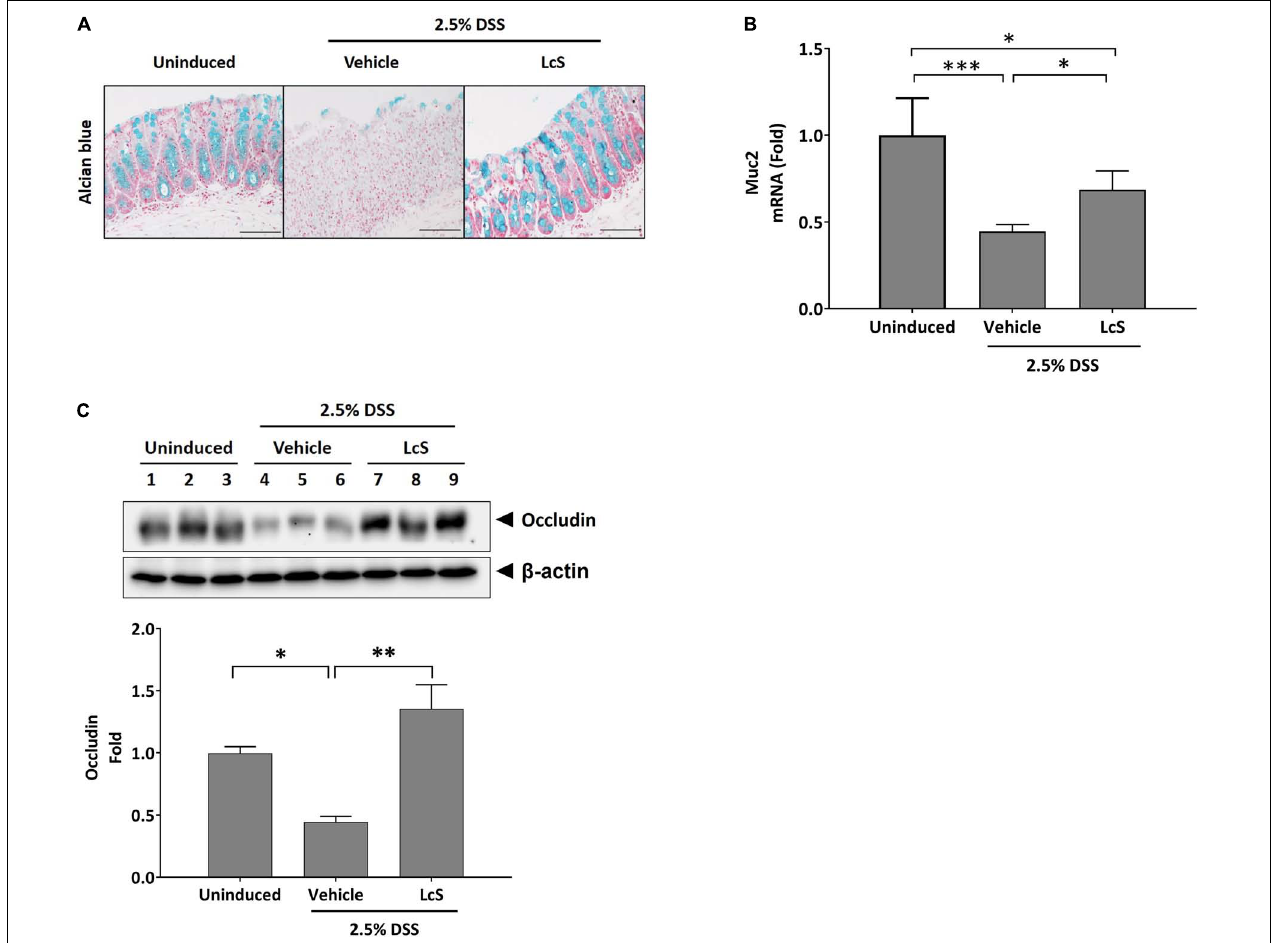
FIGURE 2 | LcS restored measures of intestinal integrity in DSS-induced mice. (A) Representative Alcian blue staining images and (B) Muc2 gene expression levels in mouse colons. Gene expression levels were normalized to uninduced mice. (C) Representative Western blot images of occludin in mouse colons. Protein expression levels were normalized to uninduced mice. Data are expressed as mean ± SEM; ∗ p < 0.05, ∗∗ p < 0.01, ∗∗∗ p < 0.001. Scale bars, 50 µ